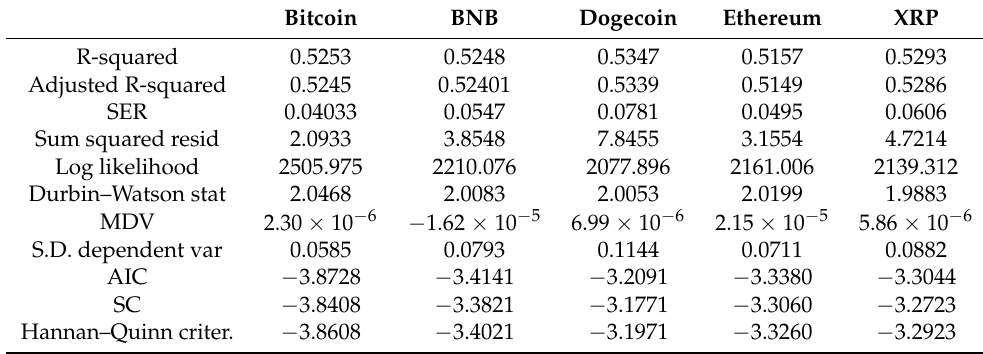
Table 7. E − GARCH: Regression Statistics of Return.